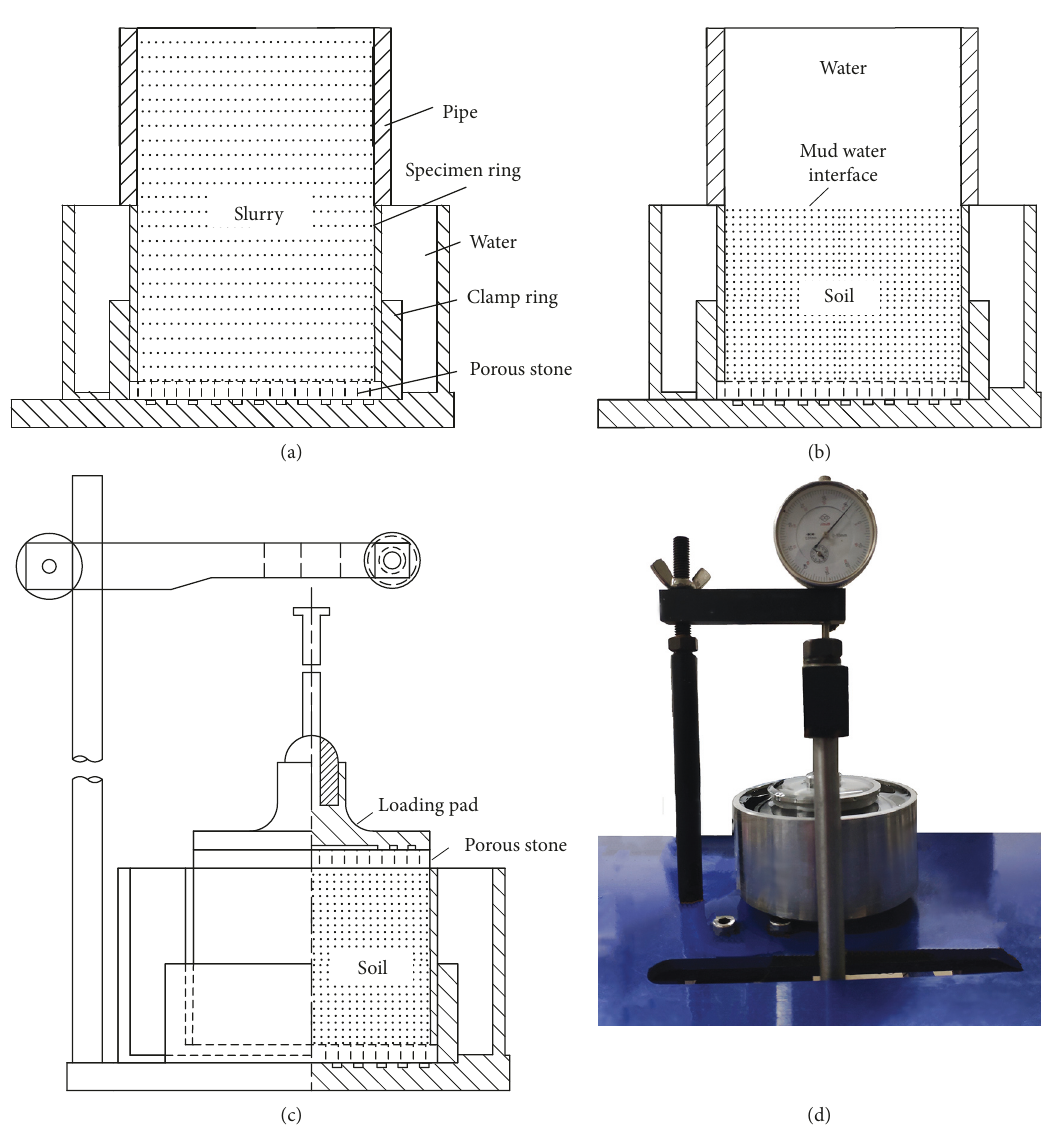
Figure 1: Consolidation method for specimen preparation. (a) Slurry before sedimentation. (b) Sedimentation for 3 days. (c) Details for consolidation test. (d) Consolidation